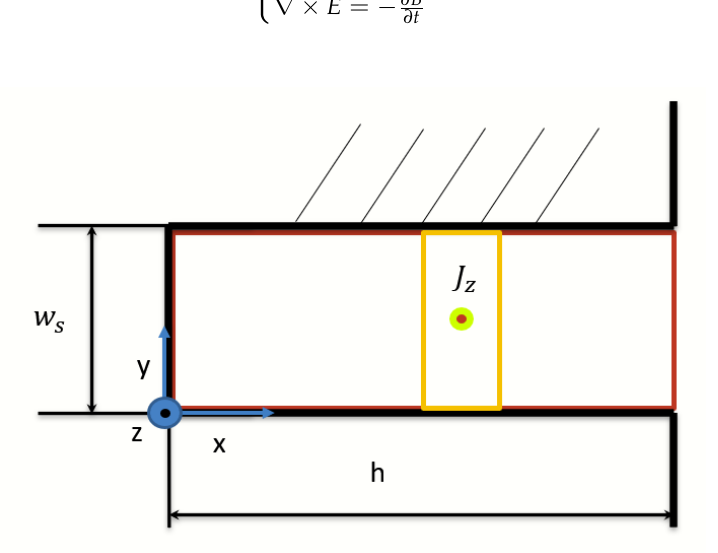
Figure 3. Single slot fully filled by a single